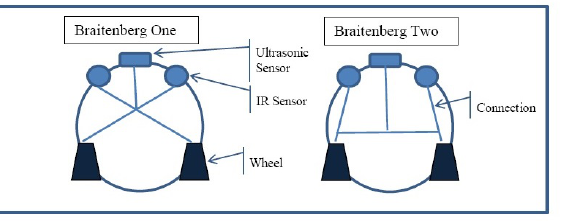
Figure 5: The two Braitenberg Vehicles used as designs for the behaviours of the ActivityBots showing alternative connection topologies.